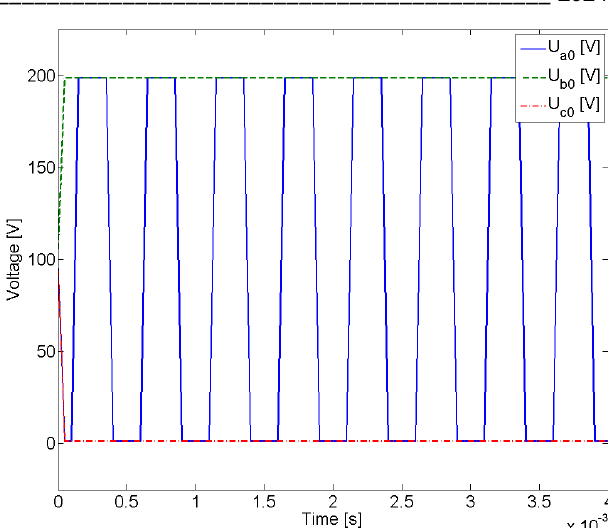
Fig. 13. The 3-phase inverter output voltages appearing on the voltage source of the finite element model in COMSOL.